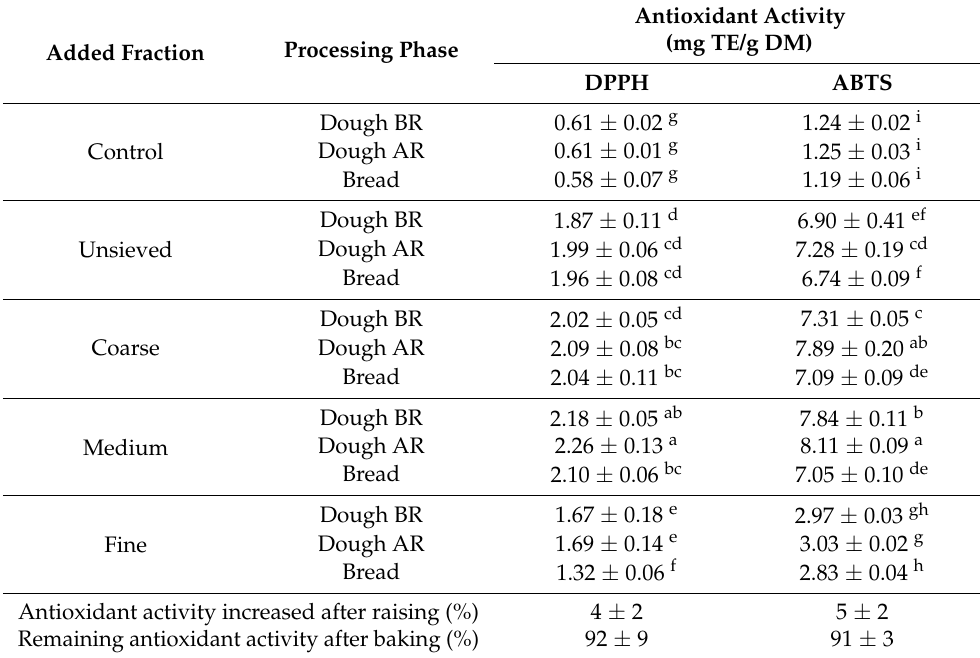
Table 4. Antioxidant activity (DPPH and ABTS) in doughs before and after raising and breads fortified with different milk thistle oilseed cake flour